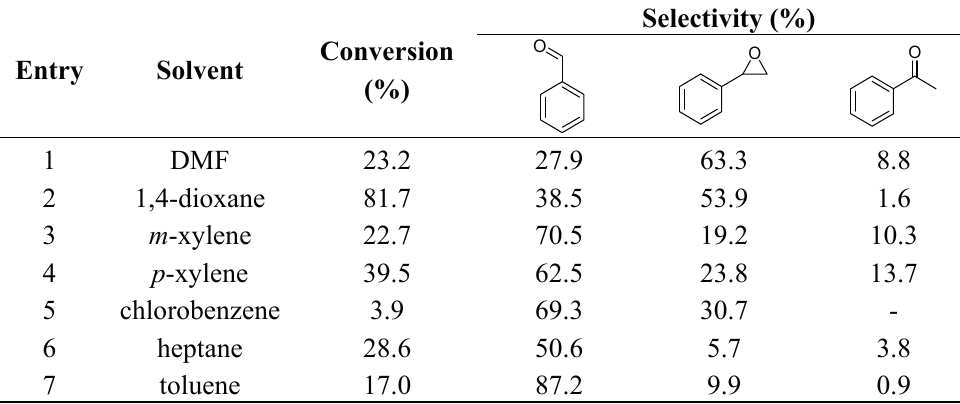
Figure 7. ( A ) The TEM and ( B ) high resolution TEM images of Au NWs; ( C ) The oxidation of styrene and ethylbenzene using Au NWs as catalysts [80]. Table 1. Catalytic performance of Au NWs on the oxidation of